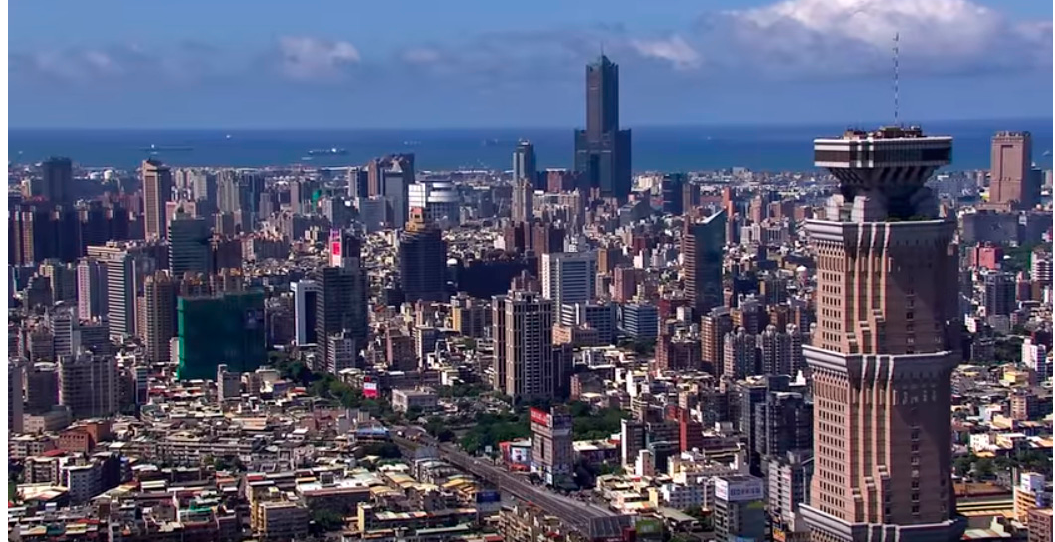
Figure 4. Kaohsiung City View. (Open Source: Kaohsiung City Government official website [20]).